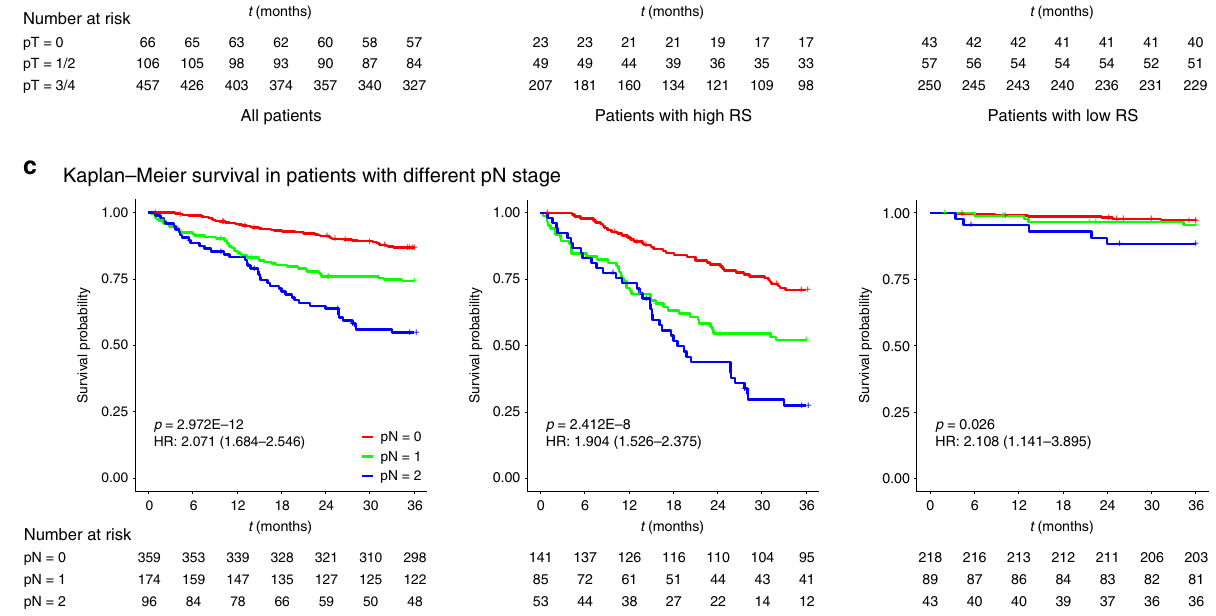
Fig. 4 K – M DMFS curves for patients with LARC according to the RS. The results are shown for all patients ( n = 629, left), patients with a high RS ( n = 279, middle), and patients with a low RS ( n = 350, right). The results are also strati fi ed according to adjuvant chemotherapy use ( a ), pT stage ( b ), and pN stage ( c ). p values were calculated using two-sided log-rank test. RS radiomic signature; HR hazard ratio; DMFS distant metastasis-free survival; LARC locally advanced rectal cancer. Source data are provided as a Source Data fi